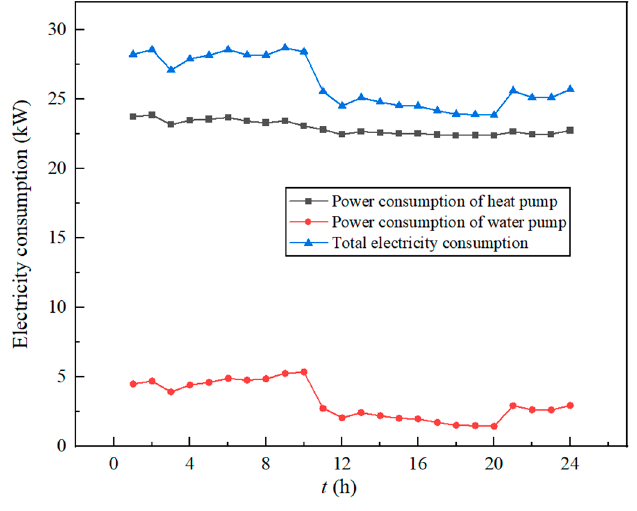
Figure 8. Electricity consumption in each period when the objective function is operating costs.